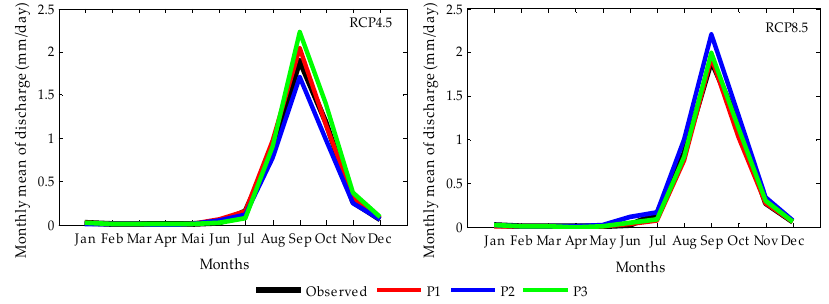
Figure 10. Evolution hydrograph of projected discharge under the RCP4.5 and RCP8.5 scenarios.